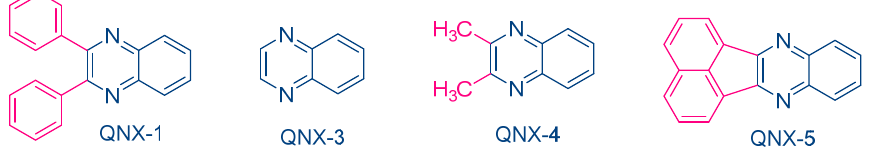
Figure 12. Quinoxalines investigated in combination with MDEA as the electron donor.